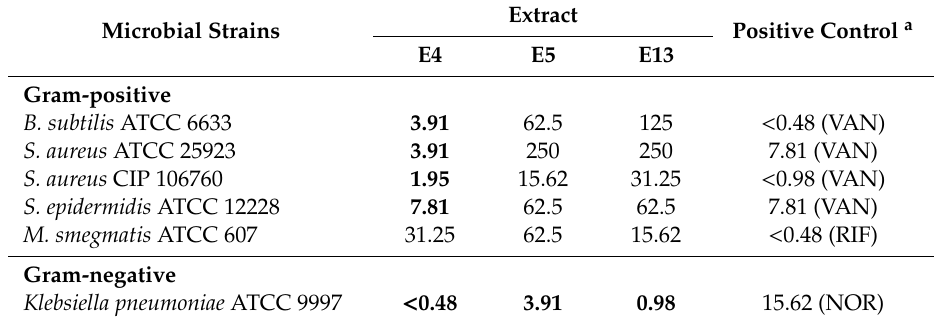
Table 3. Minimum inhibitory concentration (MIC) values ( µ g / mL) for the most active Plectranthus spp. extracts.